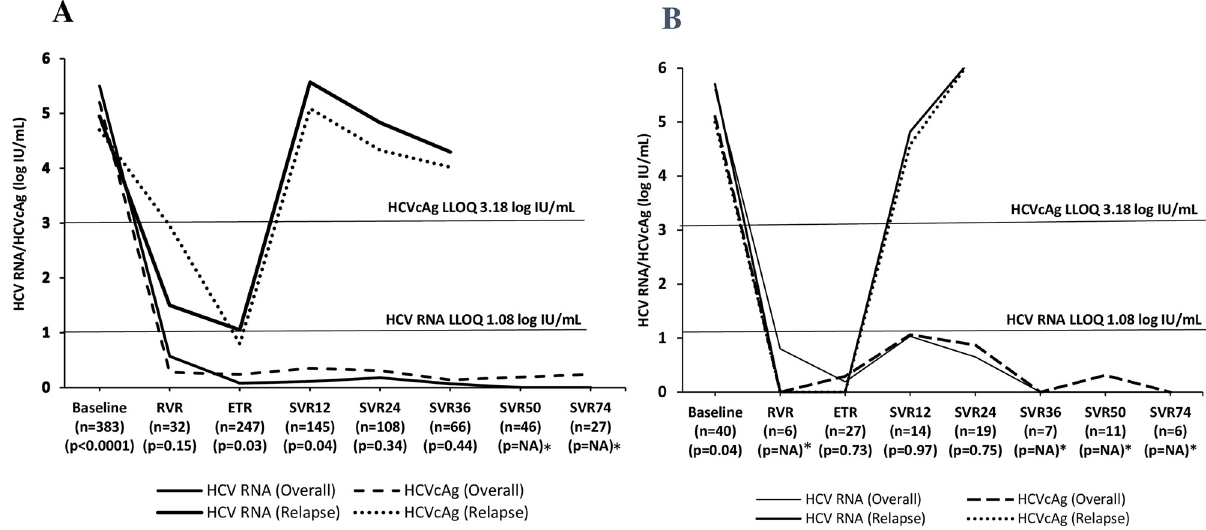
Fig 3. Kinetics of HCV RNA & HCVcAg at various time points. (A) Treatment-na ï ve (n = 383). (B) Previously treated (n = 40). Abbreviations: HCV, hepatitis C virus; HCVcAg, hepatitis C virus core antigen; LLOQ, lower limit of quantification RVR, rapid virological response; ETR, end of treatment response; SVR, sustained virological response; � NA: not applicable.